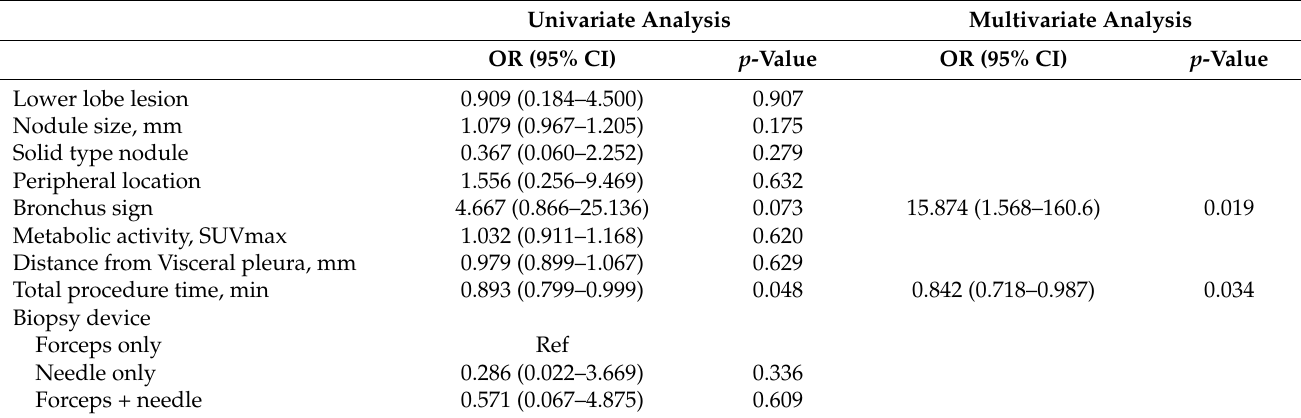
Table 3. Univariate and multivariable analysis of factors associated with the diagnostic yield.